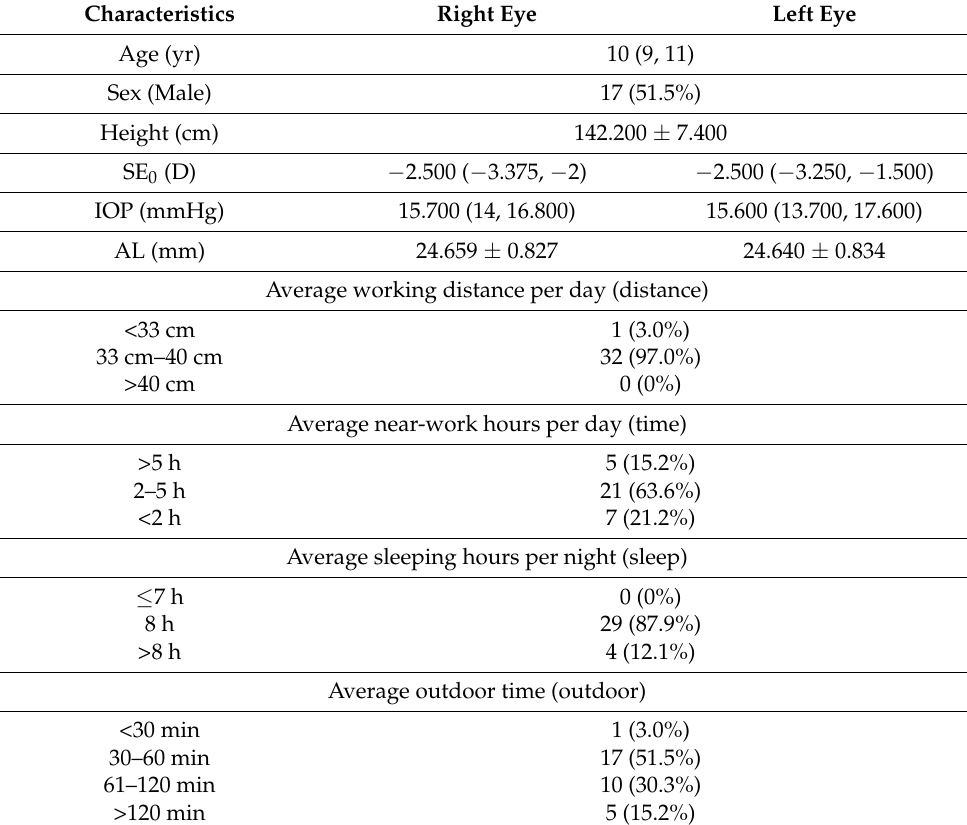
Figure 2. The binocular SFChT changes over the one-year follow-up. * represents p < 0.05; *** represents p < 0.001; all the data were from right eyes of the subjects. ## represents p < 0.01; #### represents p < 0.0001; all the data were from left eyes of the subjects. Bars represent mean; error bars stand for the standard deviation of the mean. Table 3. Baseline data of the